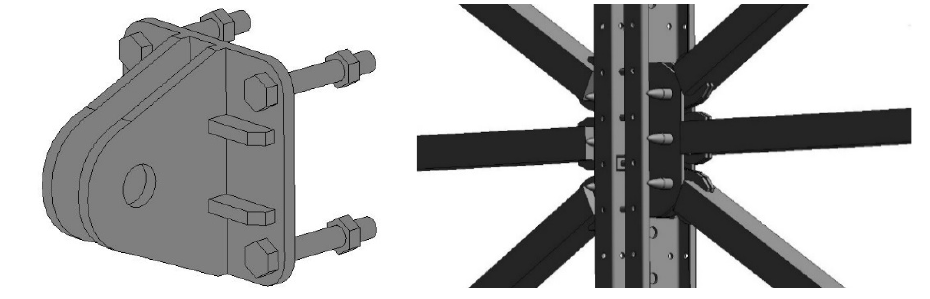
Figure 10. Assembled components.